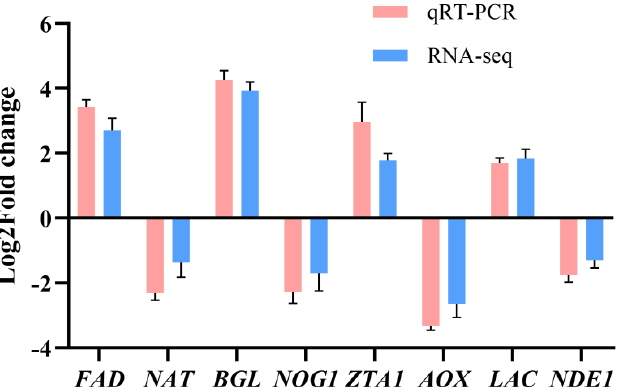
Figure 10. Validation of the DEGs in different comparisons using qRT-PCR. The expression level of each gene was normalized by the level of GADPH as reference gene. each gene was normalized by the level of GADPH as reference